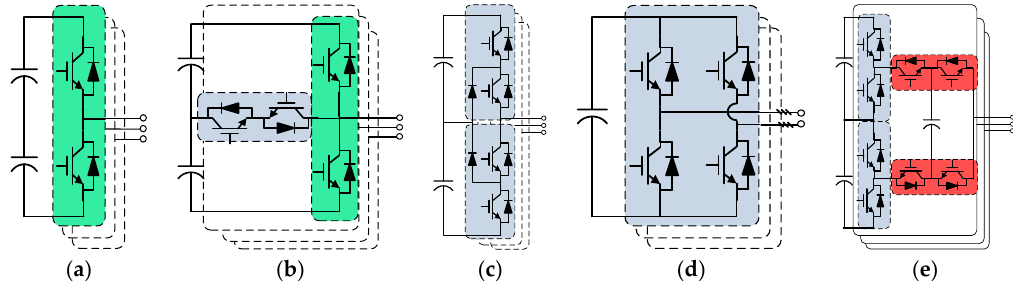
Figure 1. Demonstration of the candidate topologies: ( a ) two-level voltage-source converter (2L-VSC); ( b ) three-level T-type converter (3L-T 2 C); ( c ) three-level neutral-point clamped converter (3L-NPC); ( d ) two-level H-bridge voltage-source converter (2L-HB); and ( e ) five-level hybrid active neutral-point-clamped converter (5L-HANPC). Green : 1700 V IGBT; blue : 1200 V IGBT; red : 650 V IGBT.